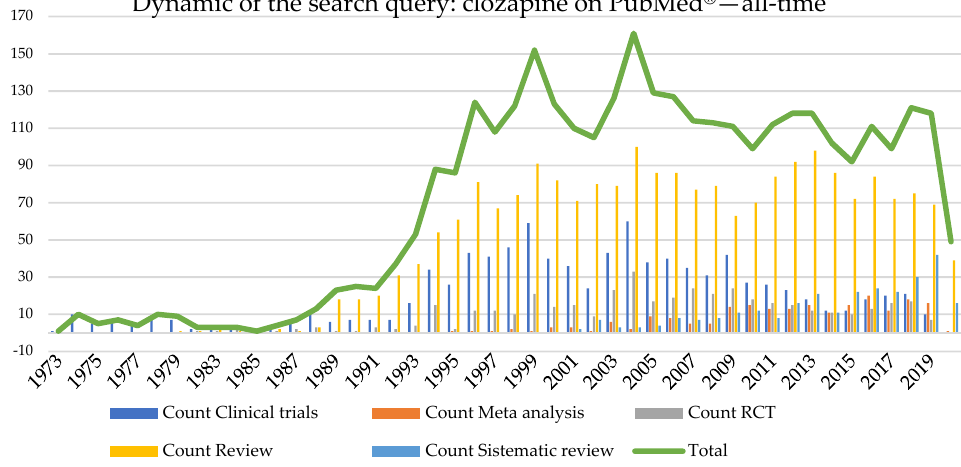
Figure 1. A systematic search for the keyword “clozapine” on the PubMed ® database (all-time topic) retrieved over 3075 results in total (RCT—Randomised Clinical Trials).